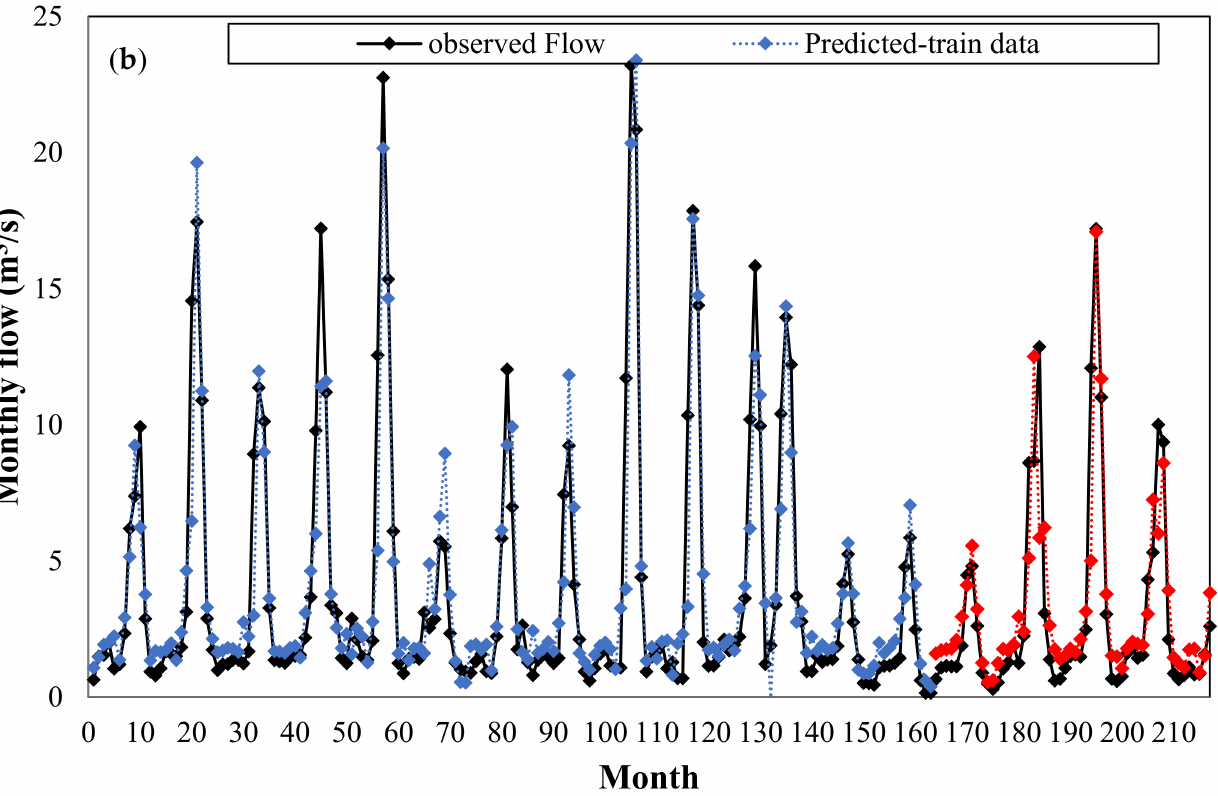
Figure 9. Comparing the observed flows with the predicted flows obtained by ( a ) KNN and ( b ) SVR-Quadratic for the period 1983–2001 for Alavian